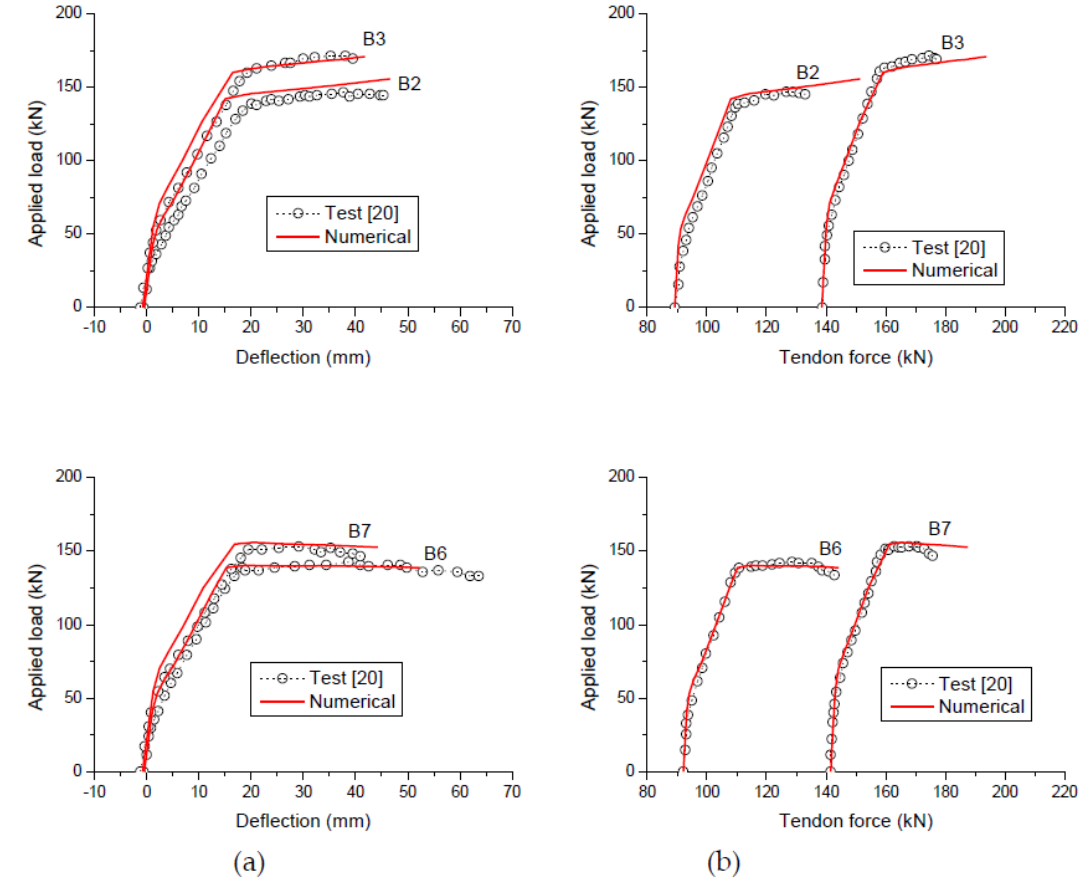
Figure 4. Verification with experimental results. ( a ) load versus midspan deflection; ( b ) load versus tendon